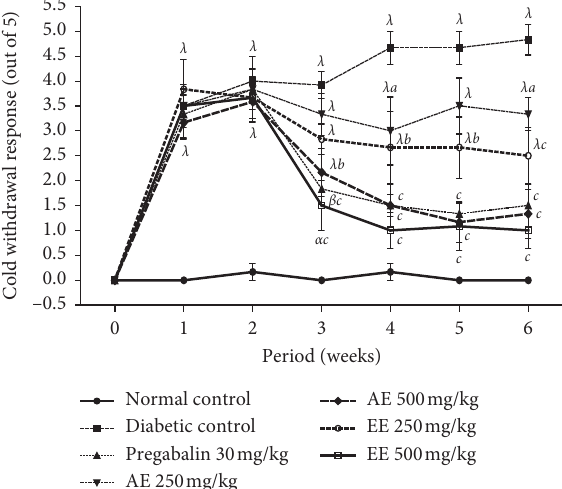
Figure 2: Effects of the aqueous (AE) and ethanol (EE) extracts of Dissotis thollonii on cold allodynia induced by acetone. Values are expressed as mean ± SEM for six animals and analyzed by two-way ANOVA followed by Bonferroni post hoc test. α p < 0 . 05, β p < 0 . 01, λ p < 0 . 001 when compared with the normal control and a p < 0 . 05, b p < 0 . 01, c p < 0 . 001 when compared with the diabetic